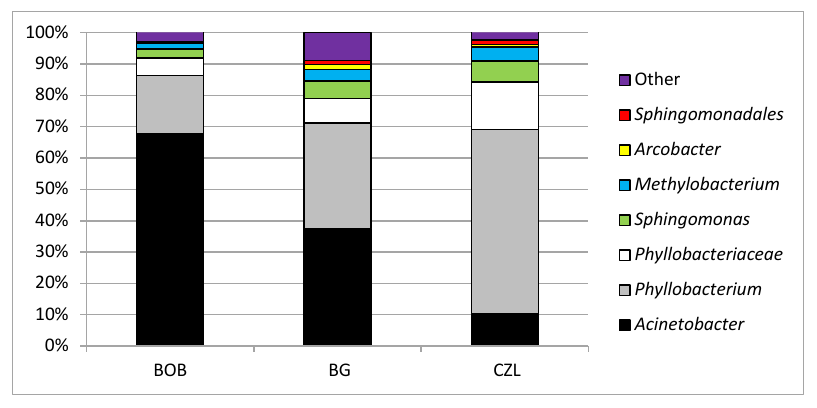
Fig. 3 Percentage of bacterial taxa inhabiting floral nectar of Polemonium caeruleum in each of three analyzed populations (see Fig. 1 for locations of